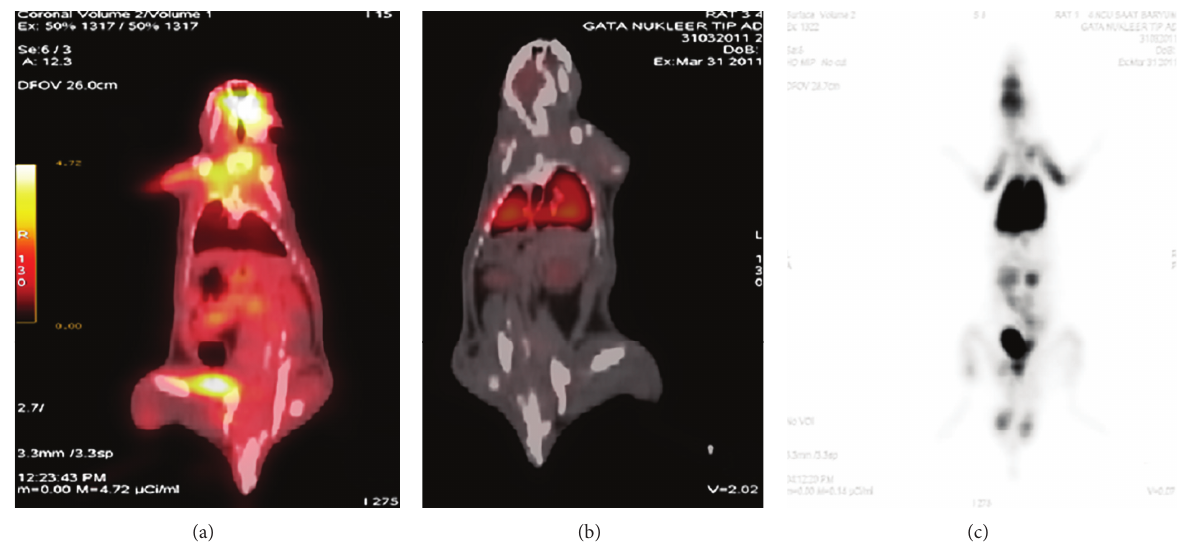
Figure 1: PET/CT image demonstrated the altered biodistribution between FDG (a) and the labeled stem cells with FDG (b). Prominent accumulation of the labeled stem cells in the lung was demonstrated by PET/CT (B) and PET image